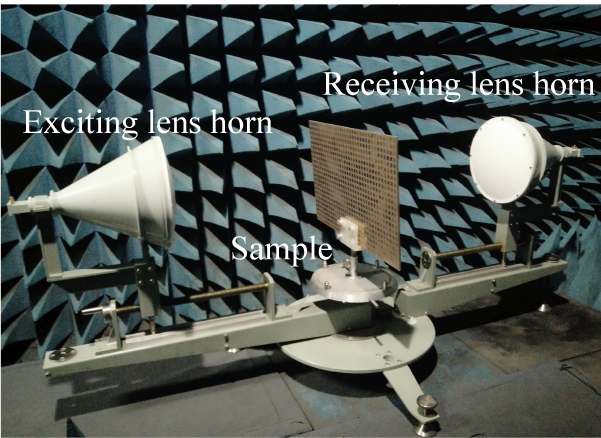
Figure 10. Photo of the measurement setup.